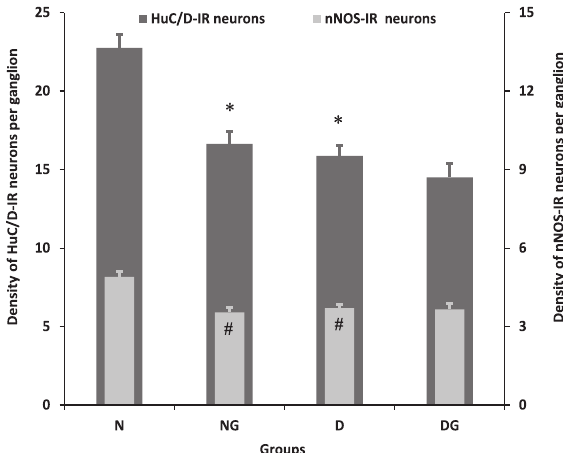
Figure 2 - Density per ganglion of HuC/D-IR and nNOS- IR myenteric neurons in normoglycemics (group N), normoglycemics supplemented with L-glutamine (group NG), diabetics (group D), and diabetics supplemented with L-glutamine (group DG). n = 5 rats per group. * P < 0.0001, compared with group N; # P < 0.0001, compared with group N. nNOS -ir n